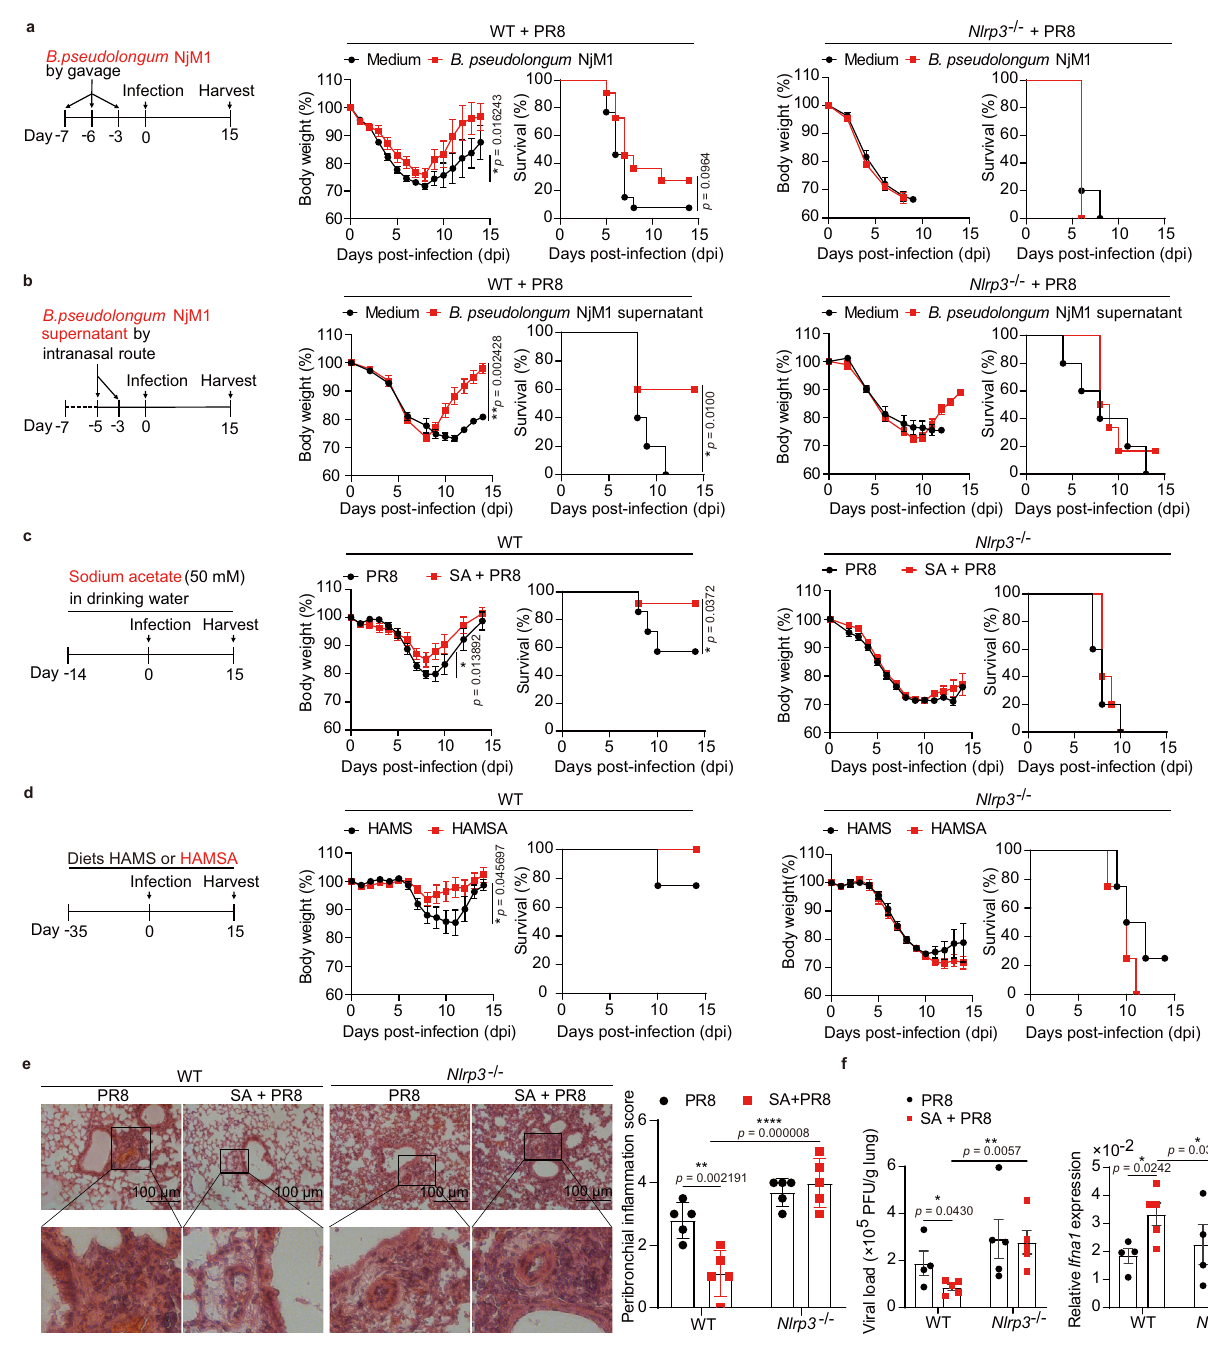
Fig. 3 | B. pseudolongum NjM1 and acetate protect WT but not Nlrp3 − / − mice againstIAVinfection.a – d WT and Nlrp3 − / − mice were given: ( a ) either 1.48 × 10 9 B. pseudolongum NjM1 or mGAM medium control for each mouse by gavage 3 times (WT, n = 11 or 13; Nlrp3 − / − , n = 10 or 10), ( b ) either 50 µ L B.